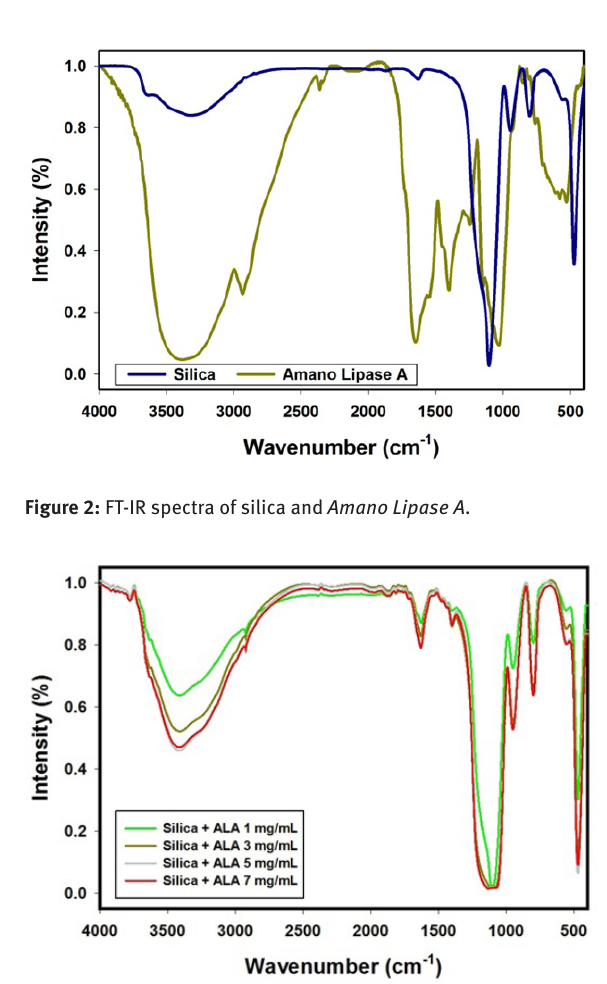
Figure 1: SEM image of obtained Stöber silica support.